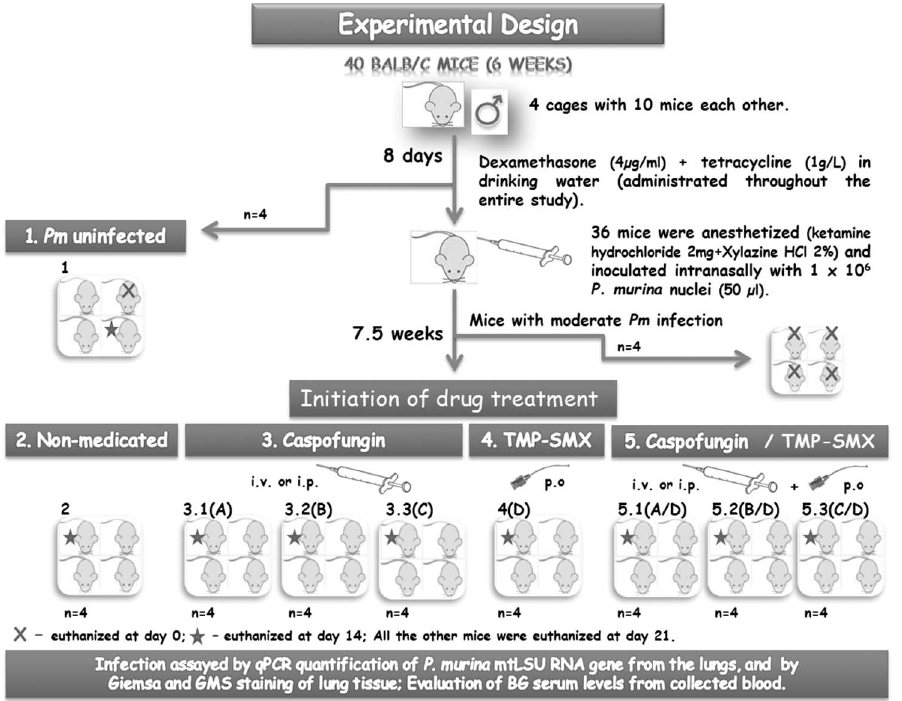
Figure 1. Experimental design of the study. The drug treatment was administered once-daily for 21 days. Four P. murina -free mice were housed separately (Group 1), serving as sentinel controls which were also sacrificed for P. murina detection at the time points day 0 (one mouse), day 14 (one mouse) and two mice at the end of the experiment (21 st day). Four mice randomly selected from the four large cages harboring immunosuppressed, P . murina infected mice, were sacrificed at the start of the study (day 0) to confirm the presence of acute P. murina infection. At the time points 14 and 21 days, mice were sacrificed according the following protocol: Group 2, Group 3 (subgroups 3.1, 3.2 and 3.3), Group 4 and Group 5 (subgroups 5.1, 5.2 and 5.3) - one mouse at day 14, and three mice at day 21. Legend: Pm - Pneumocystis murina ; n– number of mice in cage; i.v.– intravenously injection; i.p. – intraperitoneal injection; p.o.– per os ; A- Dose level of caspofungin: 0.1 mg/kg per day; B- Dose level of caspofungin: 0.05 mg/kg per day; C - Dose level of caspofungin: 0.001 mg/kg per day; D – TMP-SMX administered by oral gavage at 12.5 mg–62.5 mg per dose (doses of 39 m l TMP-SMX pediatric suspension were administered. The dose was calculated taking into account the average weight of 25 g per mouse and an initial suspension of TMP 8 mg/ml + SMX 40